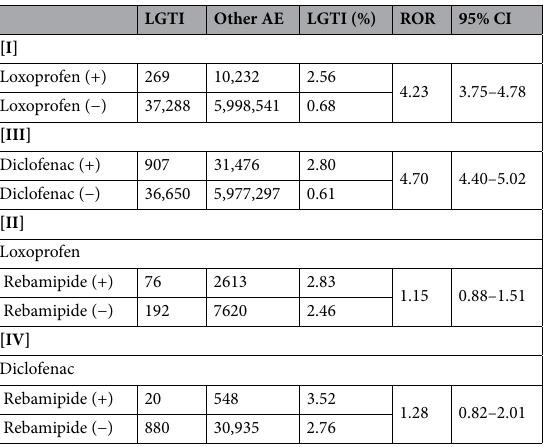
Table 1. Number of cases and ROR (95% CI) of each NSAID-induced lower gastrointestinal tract injury adverse event reported in FAERS. Lower gastrointestinal tract injury of single-drug NSAIDs [I], [III]. Lower gastrointestinal tract injury with concomitant use of rebamipide and NSAIDs [II], [IV]. LGTI lower gastrointestinal tract injury, AE adverse event.